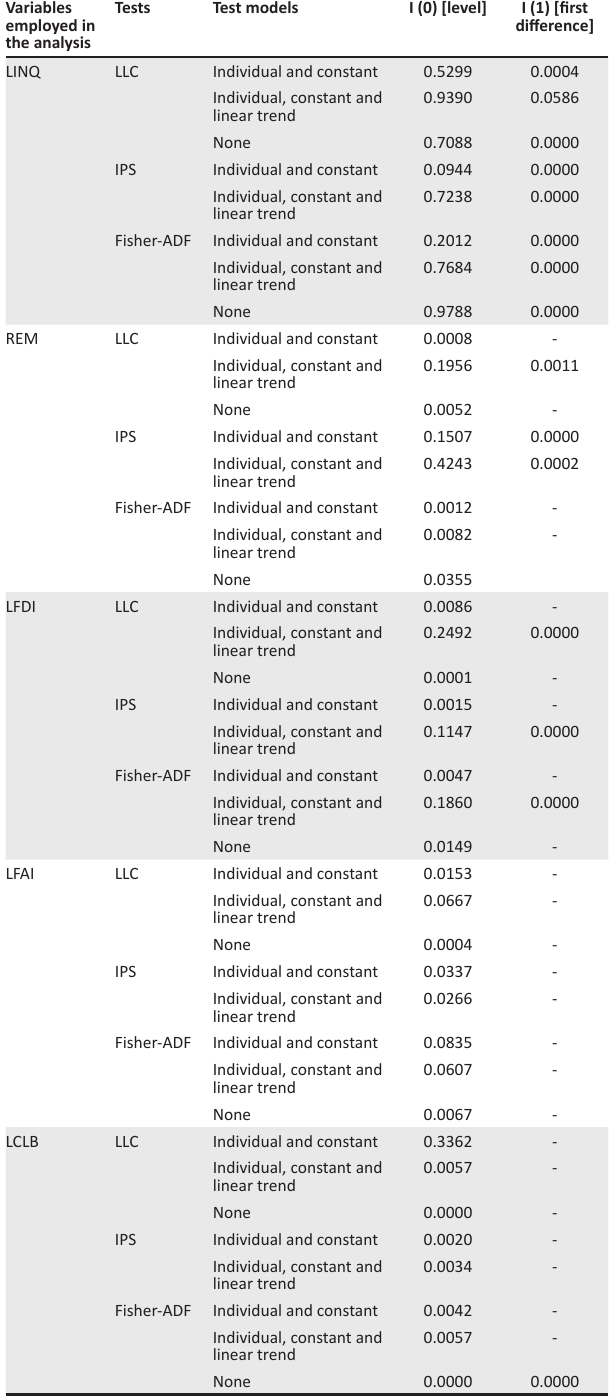
TABLE 1: Panel unit roots test